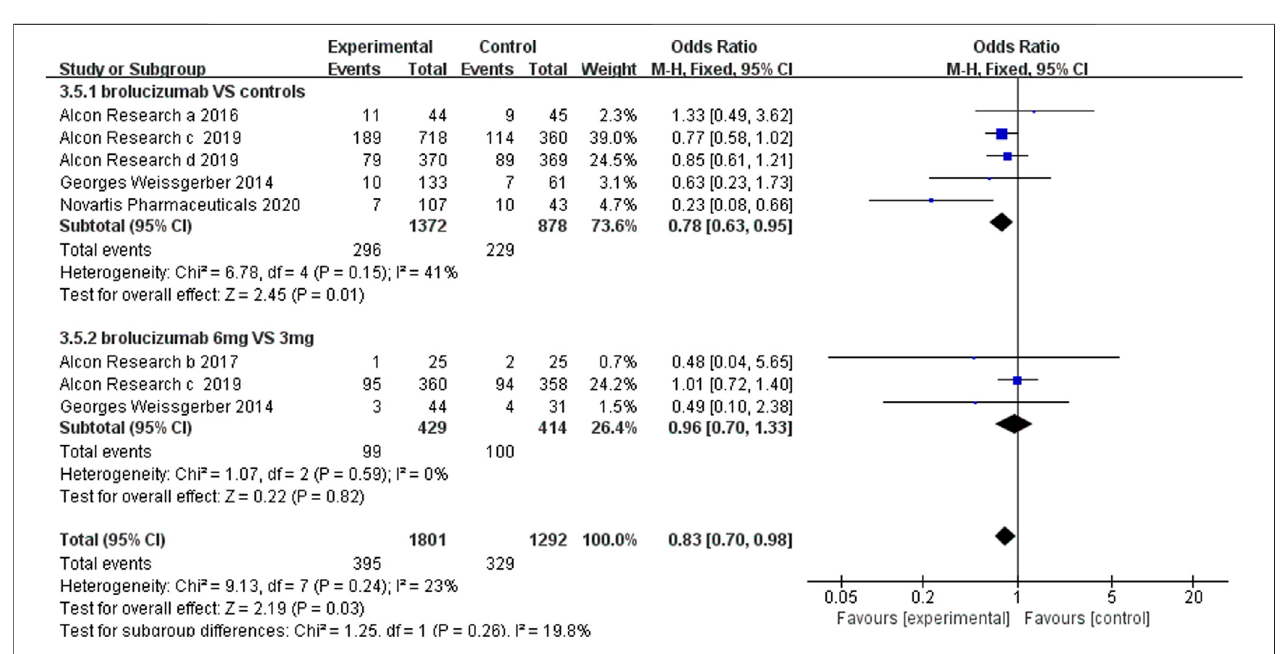
( Figure 4 ). Low heterogeneity was found in the pooled synthesis with I 2 = 0%.